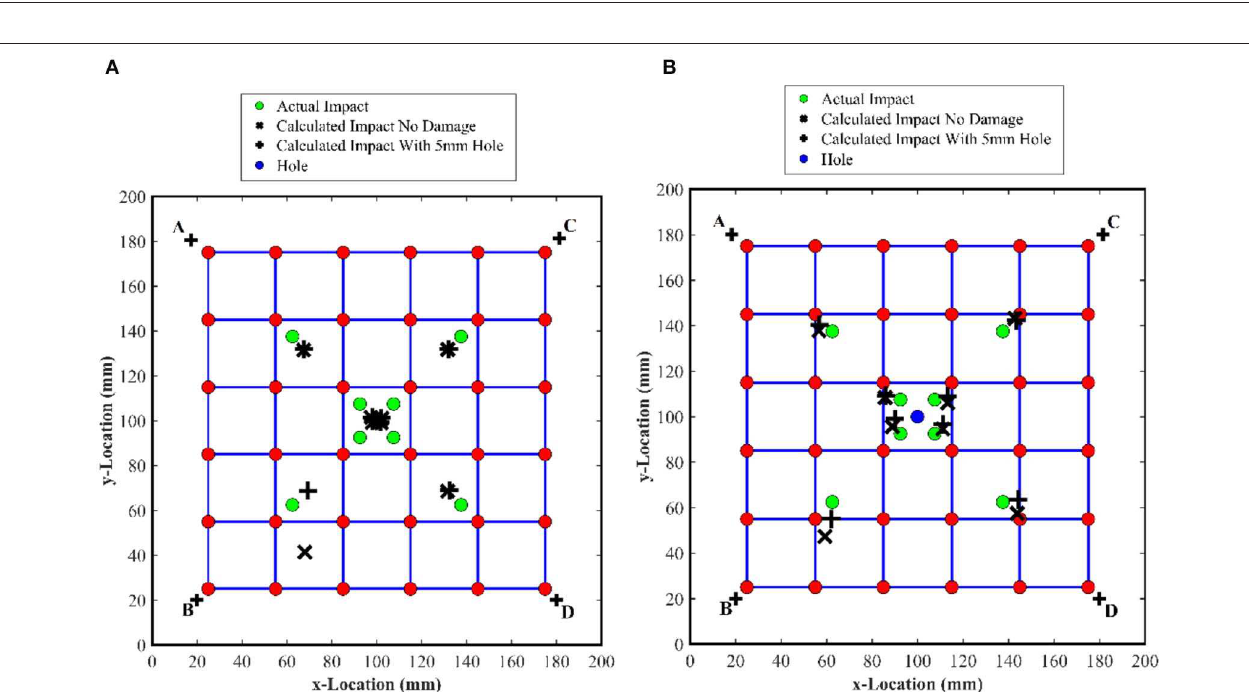
FIGURE 10 | The CoG method (A) and the MA approach (B) applied to TR with grid refinement in the damaged plate.